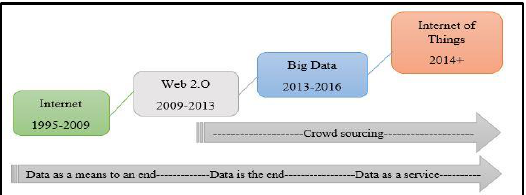
Figure 1: Evolution of